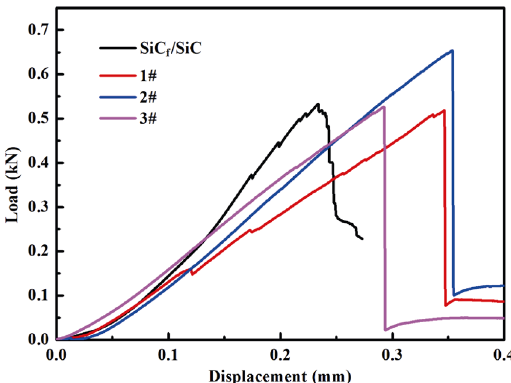
Fig. 3 Three-point bending test load–displacement curves of as-fabricated